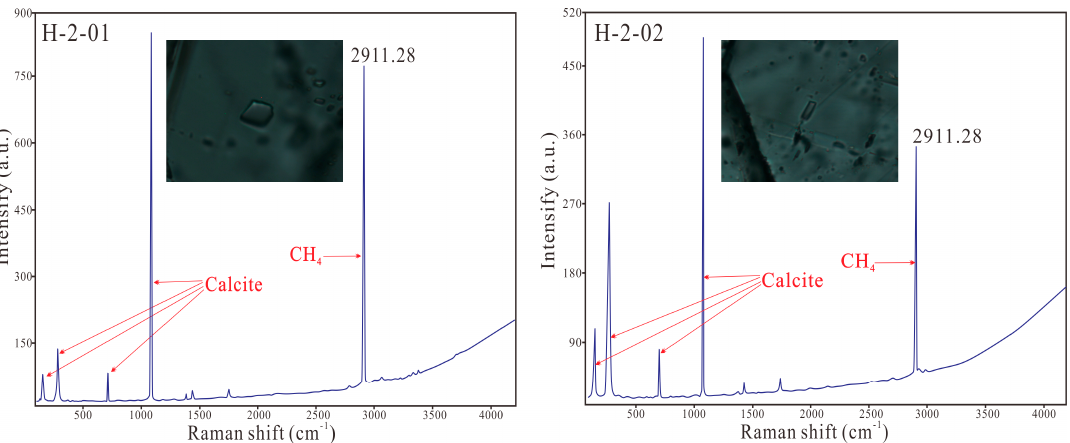
Figure 6. Laser Raman spectra of the methane inclusions in fibrous calcite vein within the Mbr 1 1 of Longmaxi Fm shale of Well H-2, Southern Sichuan Basin. The Raman scattering peaks representing the host mineral calcite are 156 cm − 1 , 283 cm − 1 , 713 cm − 1 , and 1086 cm − 1 .